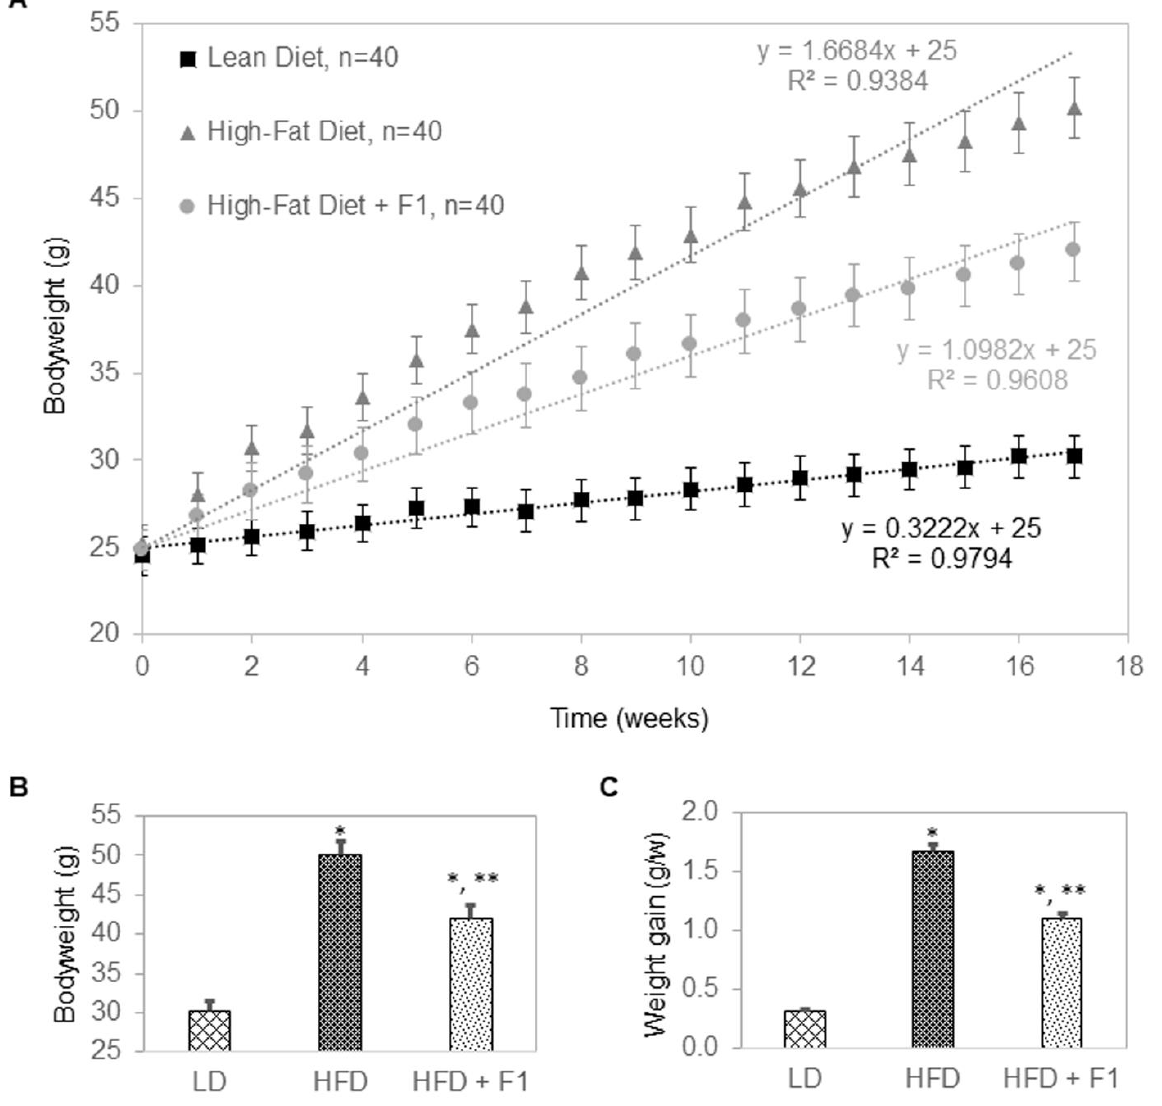
Figure 9. F1 composition reduces weight gain in diet-induced obesity mice. ( A ) Average bodyweight as a function of time of LD, HFD, and HFD + F1 animal groups. ( B ) Average bodyweight at week seventeen as a function of LD, HFD, and HFD + F1 animal groups. ( C ) Average rate of weight gain in grams per week (g/w) as a function of LD, HFD, and HFD + F1 animal groups. Error bars are standard deviations of forty mice per animal group. Single and double asterisks indicate a statistical significance of p -value ≤ 0.01 versus LD and HFD animal groups, respectively.